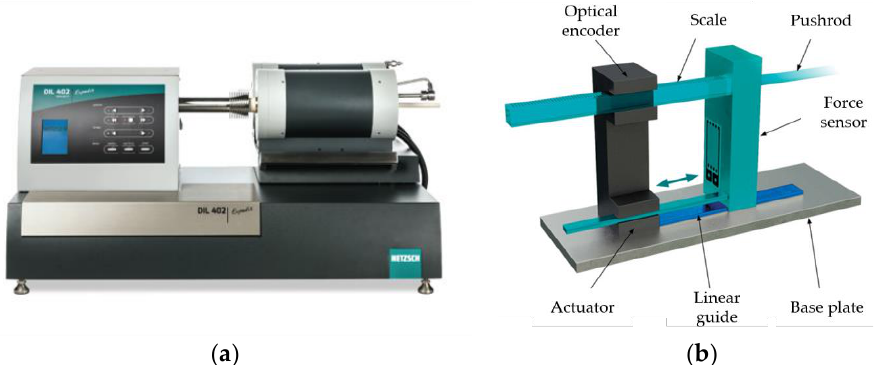
Figure 6. Measuring equipment and principle of thermal expansion curve. ( a ) Measuring equipment and ( b ) schematic diagram of measurement principle.